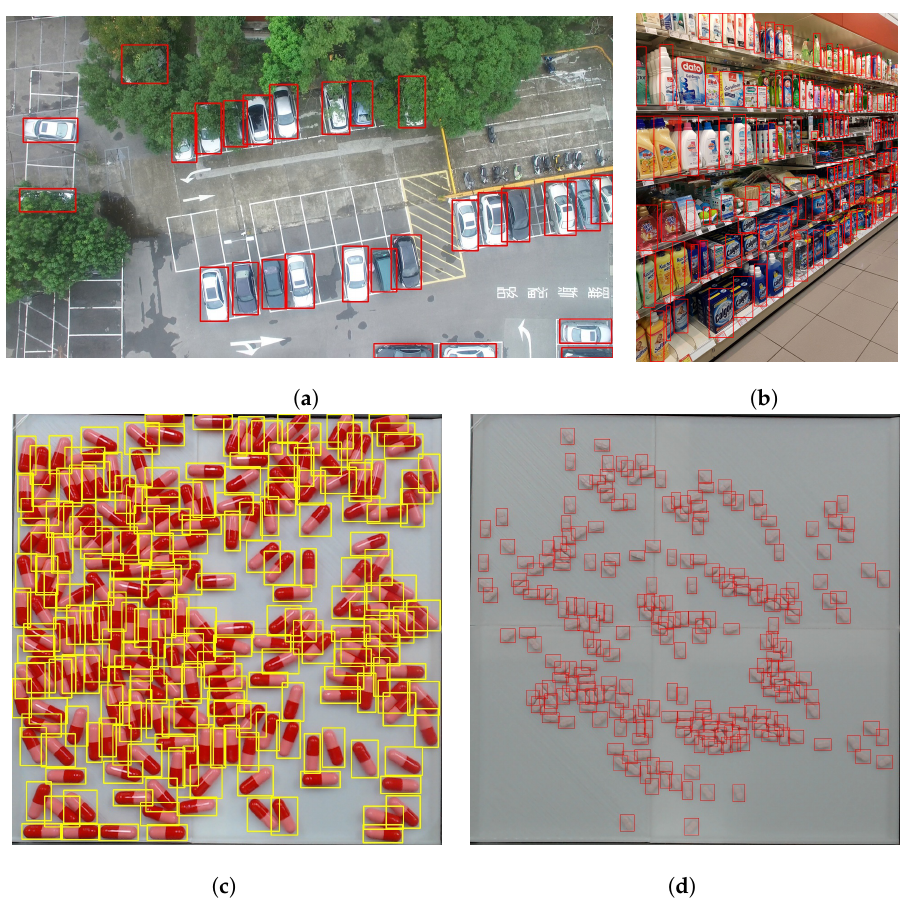
Figure 9. Dataset samples: ( a ) CARPK [15]; ( b ) SKU-110k [16]; ( c,d ) Pill